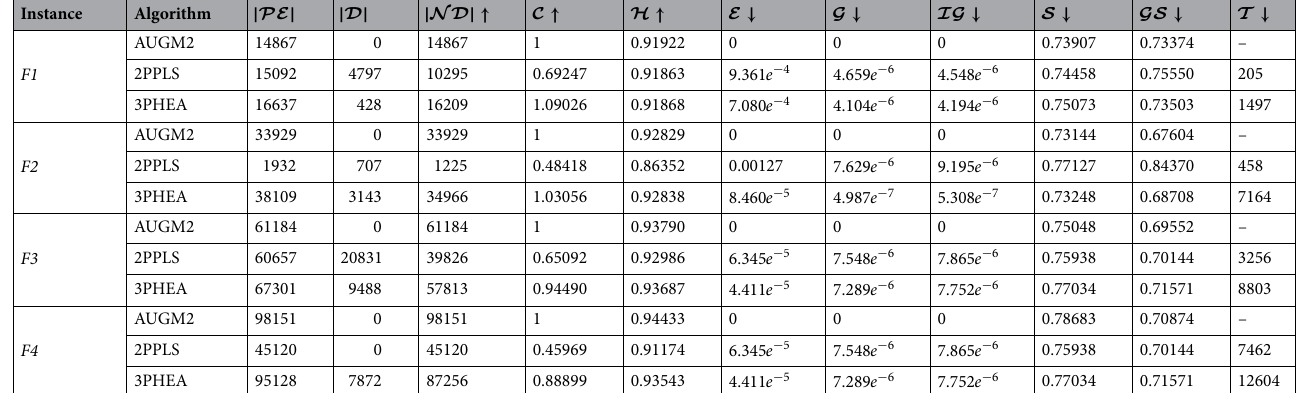
Table 8. Experimental results for datasets (Florios and Mavrotas 48 ). | PE | : Number of potentially